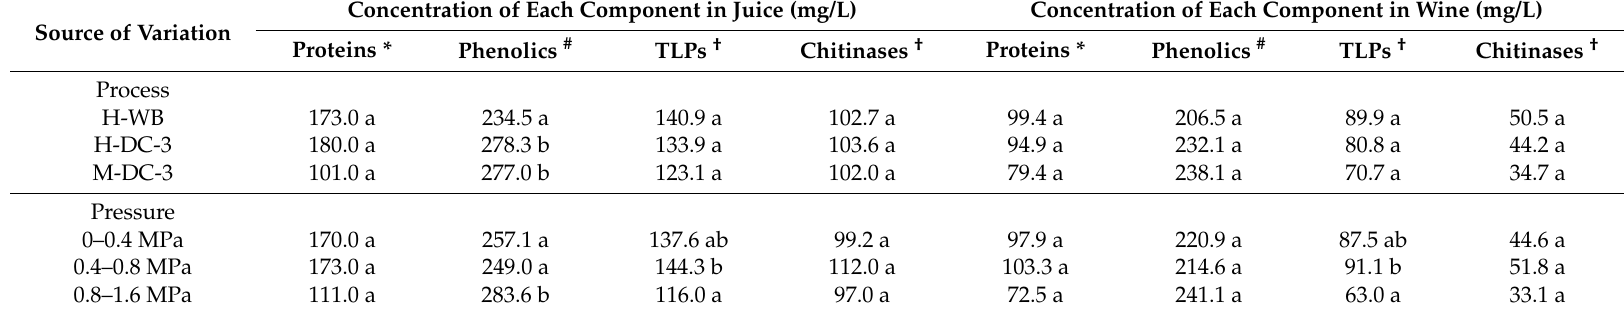
Table 4. Statistical analysis of juices and wines obtained from the separate pressing fractions in